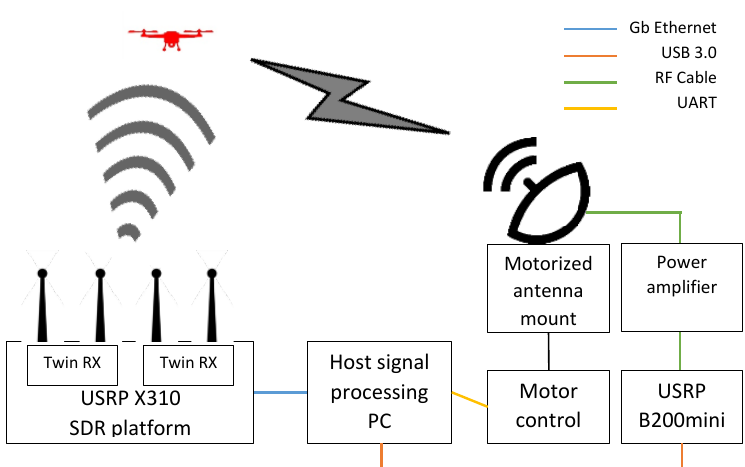
Figure 2. Block diagram of the DronEnd ground defense system.